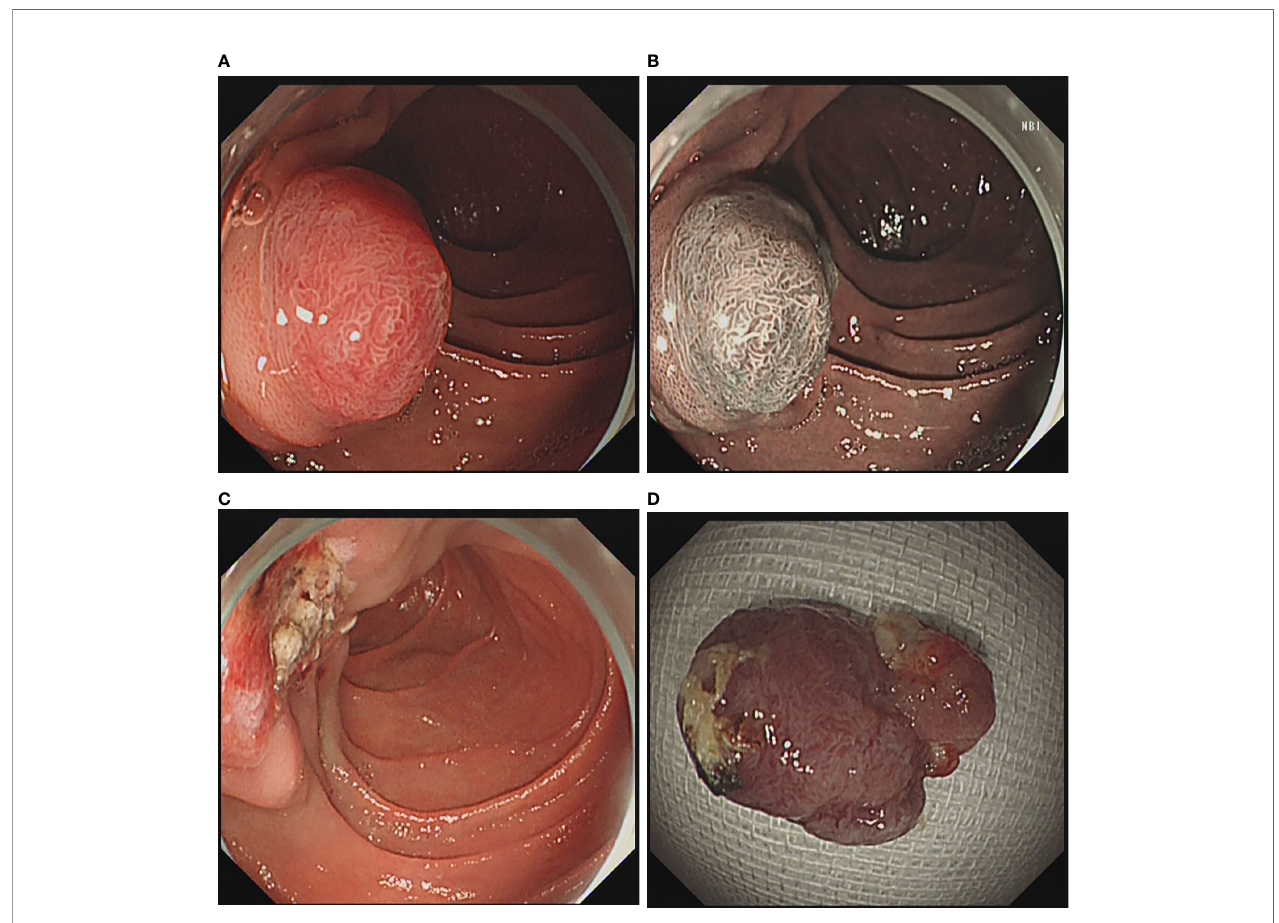
FIGURE 1 | EMR for duodenal papillary lesions. (A) Lesion at the duodenal papillary; (B) Duodenal papillary lesion in NBI mode; (C) Wound after lesion resection; (D) Lesion after